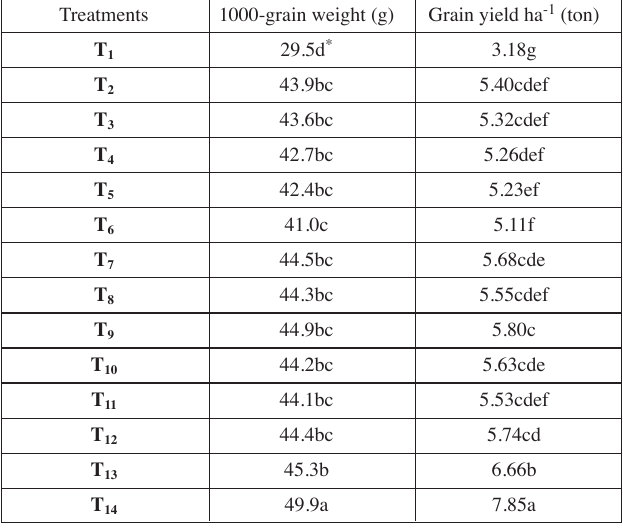
* Values are means (n = 9), and mean values in each column followed by a dif- ferent lower-case-letter are significantly different by Fisher’s least-significant difference test (LSD) at P ≤ 0.05. T 1 : Control (without any N-fertilizer); T 2 : Recommended N as ammonium